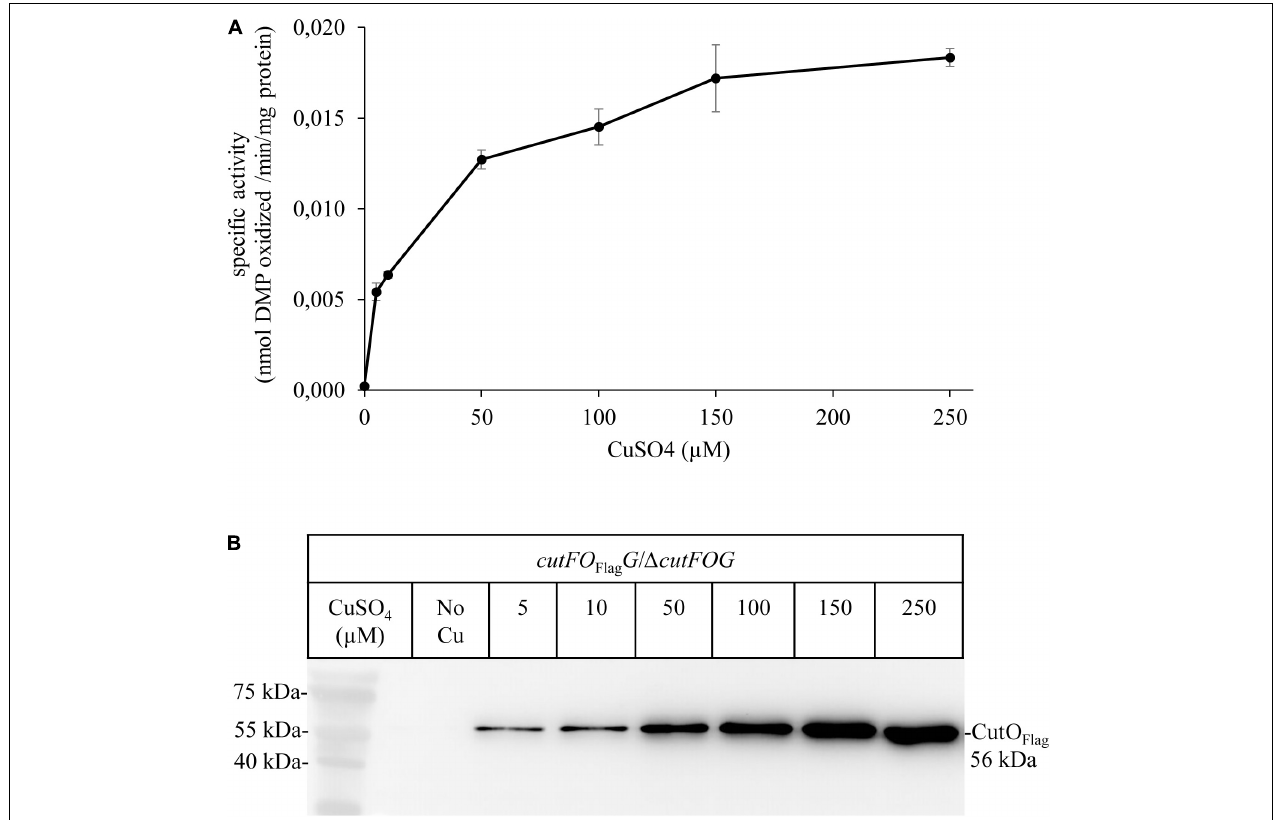
FIGURE 9 | Activity and steady-state levels of CutO are Cu-dependent. (A) The activity of plasmid-encoded Flag-tagged CutO ( cutFO Flag G ) expressed in the (cid:49) cutFOG strain, grown in MPYE medium supplemented with different CuSO 4 concentrations. 50 µ g protein of the periplasmic fractions were used for the assay. Shown are the mean values of three independent assays with three technical repetitions and the error bars reflect the standard deviation ( n = 9). (B) For immunoblot analysis of the CutO Flag , approximately 40 µ g of periplasmic proteins were separated on 15% SDS-PAGE and treated with anti-Flag antibodies.